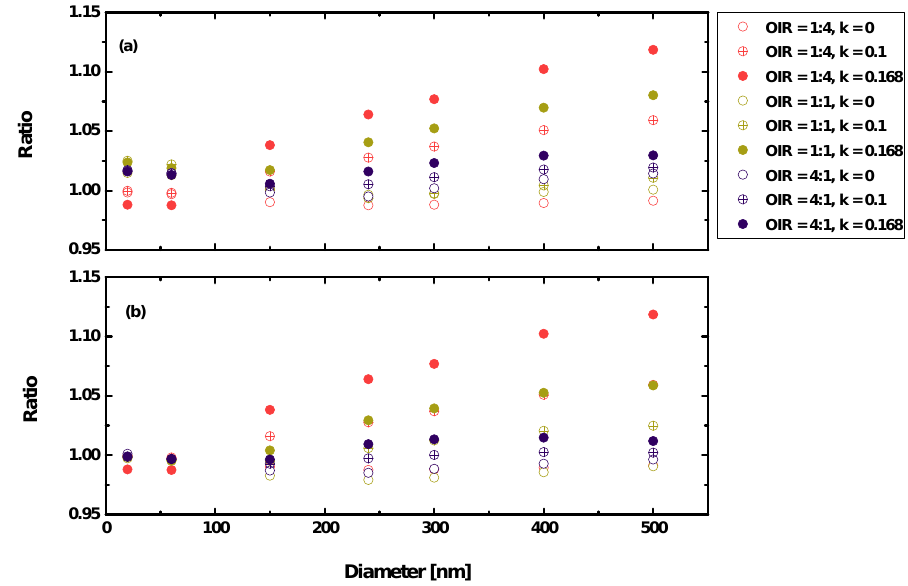
Figure 9. Ratio of radiative forcing of LLPS to the homogenous case under 70%RH (a) and dry conditions (0%RH) (b) for AAE = 2 and albedo a = 0.